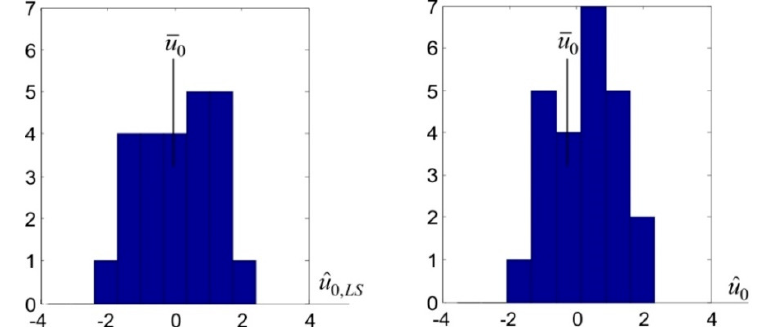
Figure 4. The histograms of least squares (LS) and total least-squares collocation (TLSC) estimators regarding zero CPs displacements.